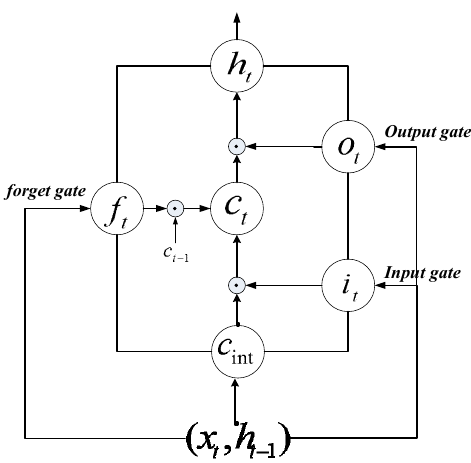
Figure 5. The structure of memory cell in LSTM.